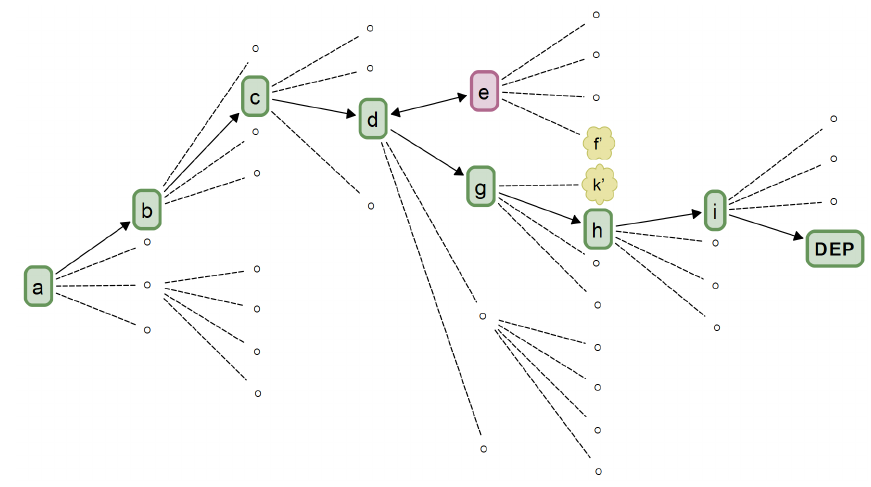
Figure 2. A simple DSpace excerpt with highlighted